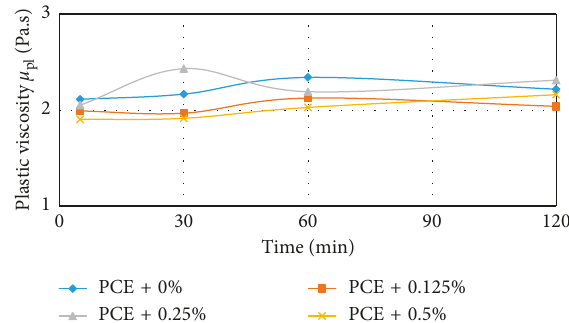
Figure 13: Variation of plastic viscosity of nanomodified cement pastes with PCE within 120min duration.